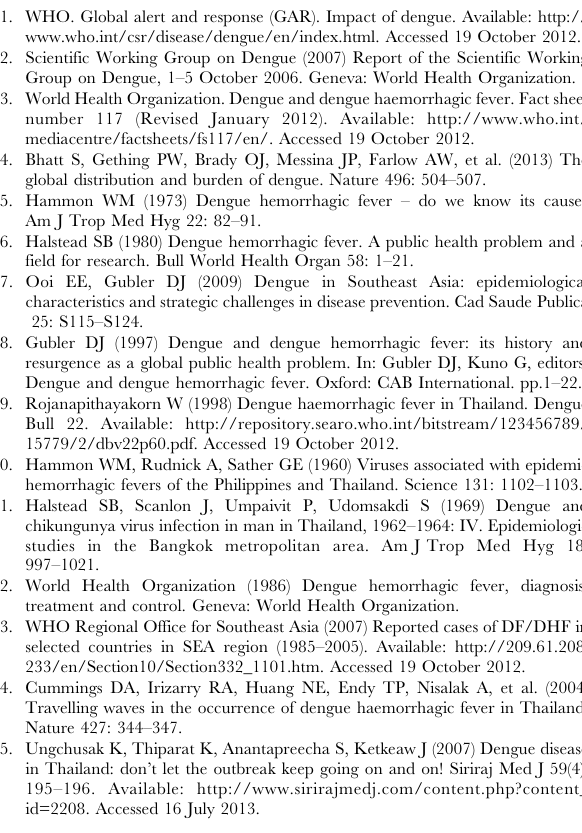
Table S3 Incidence of dengue disease in Thailand: regional data. Table S4 Age-specific patterns of dengue disease in Thailand. Table S5 Serotype distribution of dengue viruses in Thailand: national and/or regional